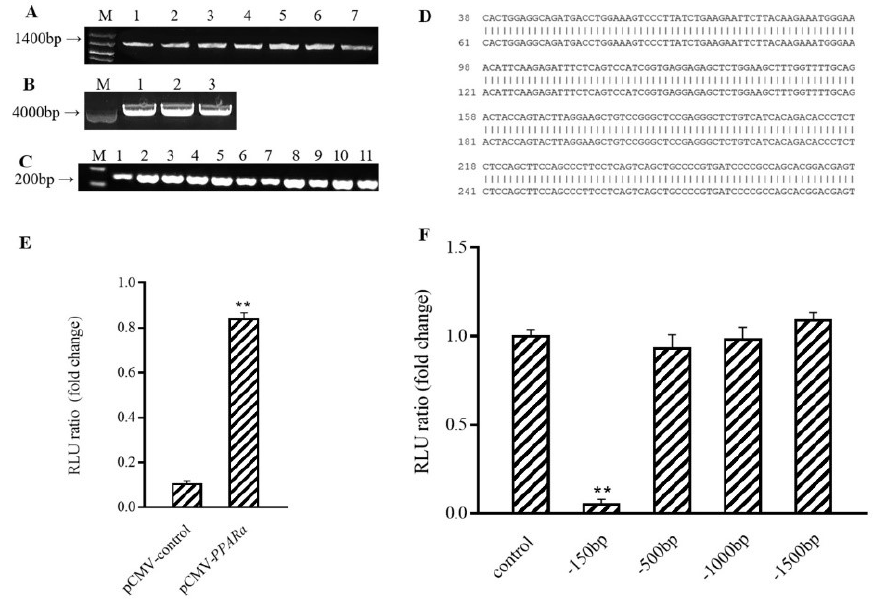
Figure 5. PPAR α binds to Ucp1 promoter to activate transcription. ( A ) Cloned PPAR α electrophoresis M: Kang Wei 200B PLA DD; Lane 1–7: PPAR α amplification product. ( B ) Electrophoresis map of pCMV-N-Flag enzyme digestion product, M: Kang Wei 200B PLA DD; Lane 1–3: